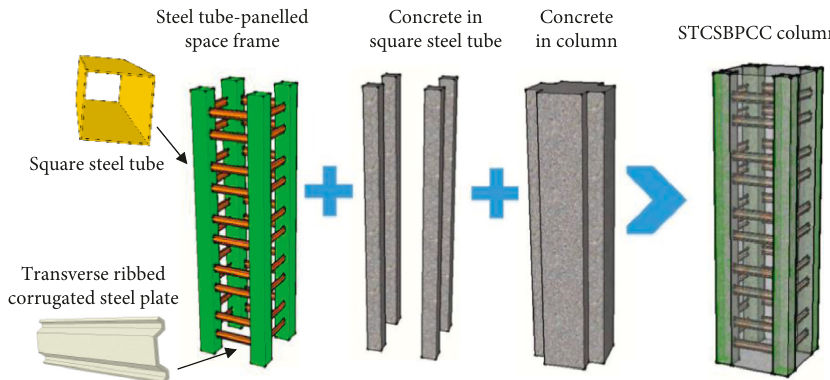
Figure 1: Schematic diagram of the composite column.